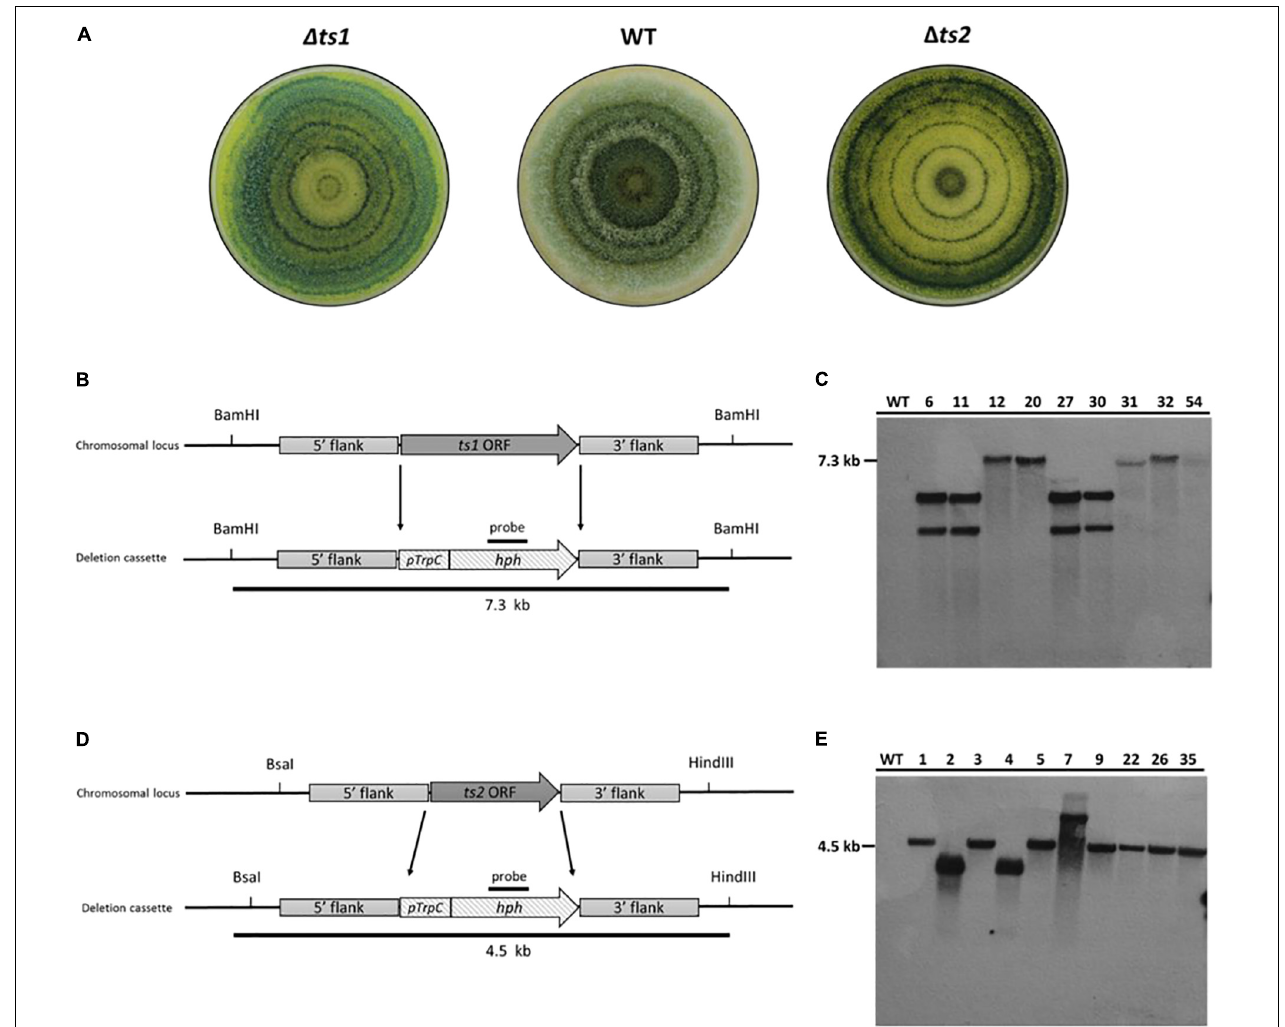
FIGURE 3 | Confirmation of homologous recombination event of the HygR cassette in deletion mutants by Southern blot. (A) Colony appearance growing on axenic media (PDA) under light/dark cycle. (B–D) Schematic representation of gene deletion strategy. The ORF of each targeted gene is replaced by the homologous integration of the PtrpC/ hph fragment (1.4 kb) that confers resistance to hygromycin B. (B) A 7.3 kb fragment would result for the ts1 deletion mutants when digested with Bam HI. (C) Southern blot analysis of T. virens WT strain and ts1 deletion mutants (6, 11, 12, 20, 27, 30, 31, 32, and 54) (D) A 4.5 kb fragment would result for the ts2 deletion mutants when digested with Bsa I and Hin dIII. (E) Southern blot of T. virens WT strain and ts2 deletion mutants (1, 2, 3, 4, 5, 7, 9, 22, 26, and 35). Expected fragments sizes for each deletion event along the left side of the